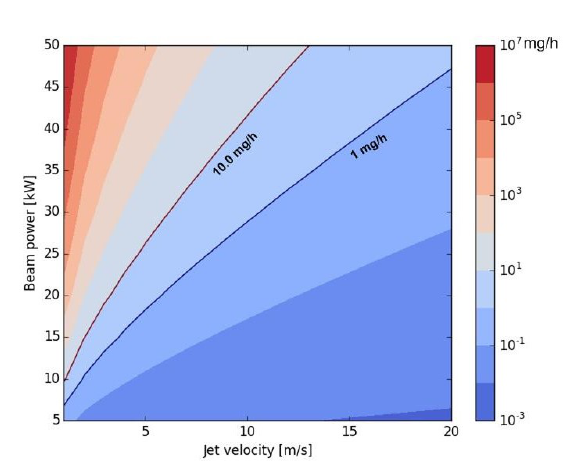
Fig. 1. Mass evaporation rate as a function of lithium velocity and beam power, for a gaussian beam parameters of  x = 8 mm and  y = 12 mm . Acceptable conditions regarding evaporation rate are below the double black line (evaporation rate below 10 mg/h). A more conservative operation limit of 1 mg/h is marked by a single black